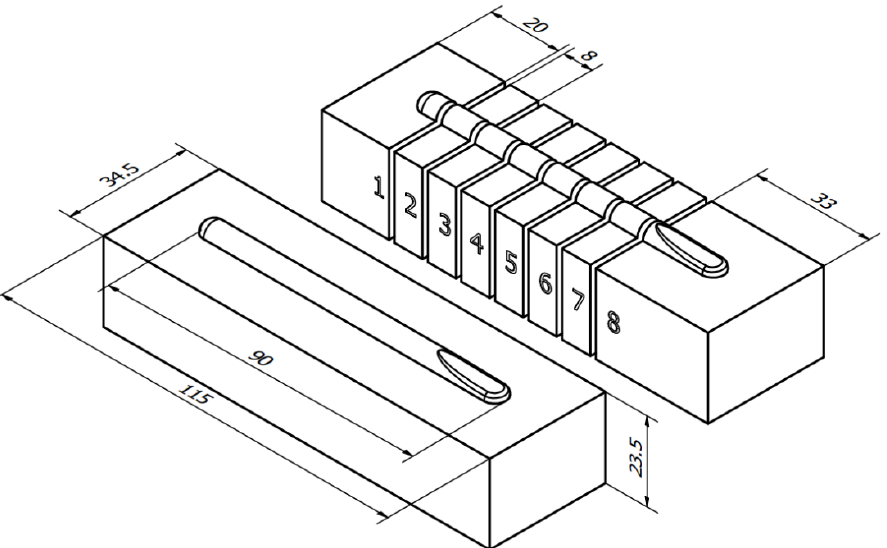
Figure 3. Specimen preparation scheme. The numbers from 1 to 8 indicate the separated slices of the hardfaced bar, used afterwards to measure the geometry and hardness.